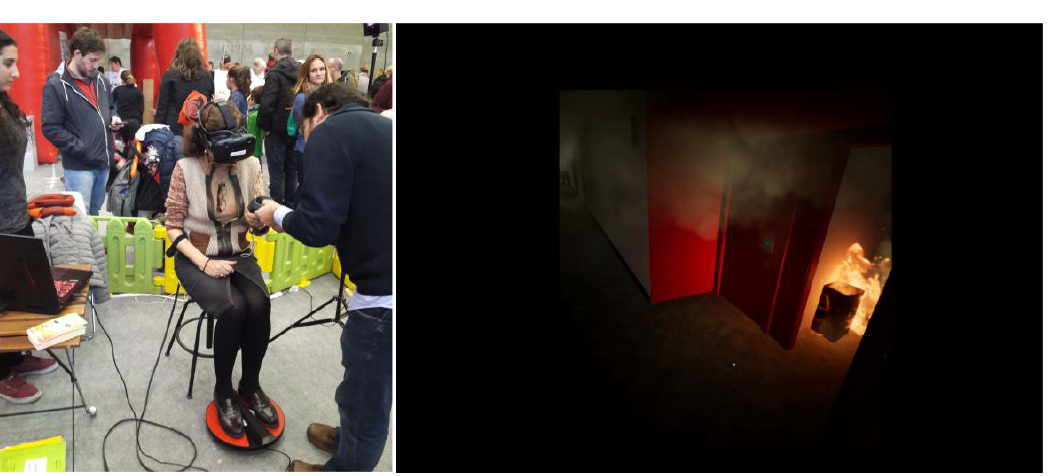
Figure 1. User experience and virtual environment.